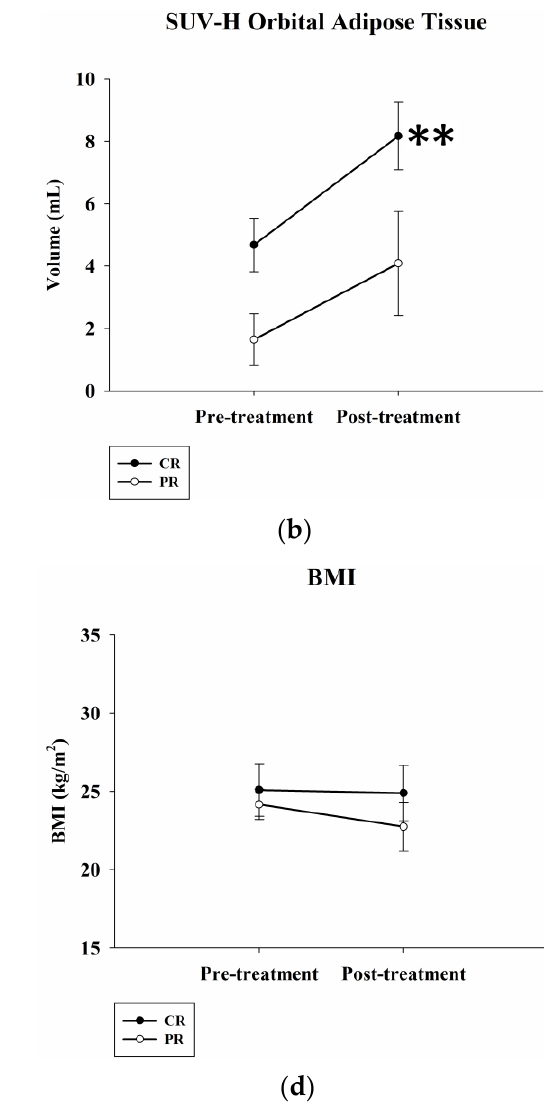
( d ) Figure 2. Pre- and post-treatment SUV-H EAT, OAT volume, serum LDH levels, and BMI, according to different treatment responses. ( a ) The SUV-H EAT volume significantly increased in responders ( p = 0.03) but decreased in non-responders ( p = 0.32). ( b ) The SUV-H OAT volume significantly in- creased in responders ( p = 0.002) but decreased in non-responders ( p = 0.19). ( c , d ) There were no significant differences between pre- and post-treatment serum LDH levels or BMI among respond- ers versus non-responders. * Differences are significant at the 0.05 level (two-tailed). ** Differences are significant at the 0.01 level (two-tailed). SUV-H EAT, high standardized uptake value epicardial adipose tissue; SUV-H OAT, high standardized uptake value orbital adipose tissue; LDH, lactate dehydrogenase; BMI, body mass index; CR, complete response; PR, partial response; PD, progres- sive disease. The pre- and post-treatment SUV-H EAT and SUV-H OAT volumes, LDH levels, and BMI in complete and partial responders were also compared. Among complete respond- ers, the SUV-H EAT and SUV-H OAT volumes significantly increased from 6.3 ± 2.0 mL to 30.5 ± 9.7 mL and 4.7 ± 0.9 mL to 8.2 ± 1.1 mL, respectively, after treatment ( p = 0.04 and